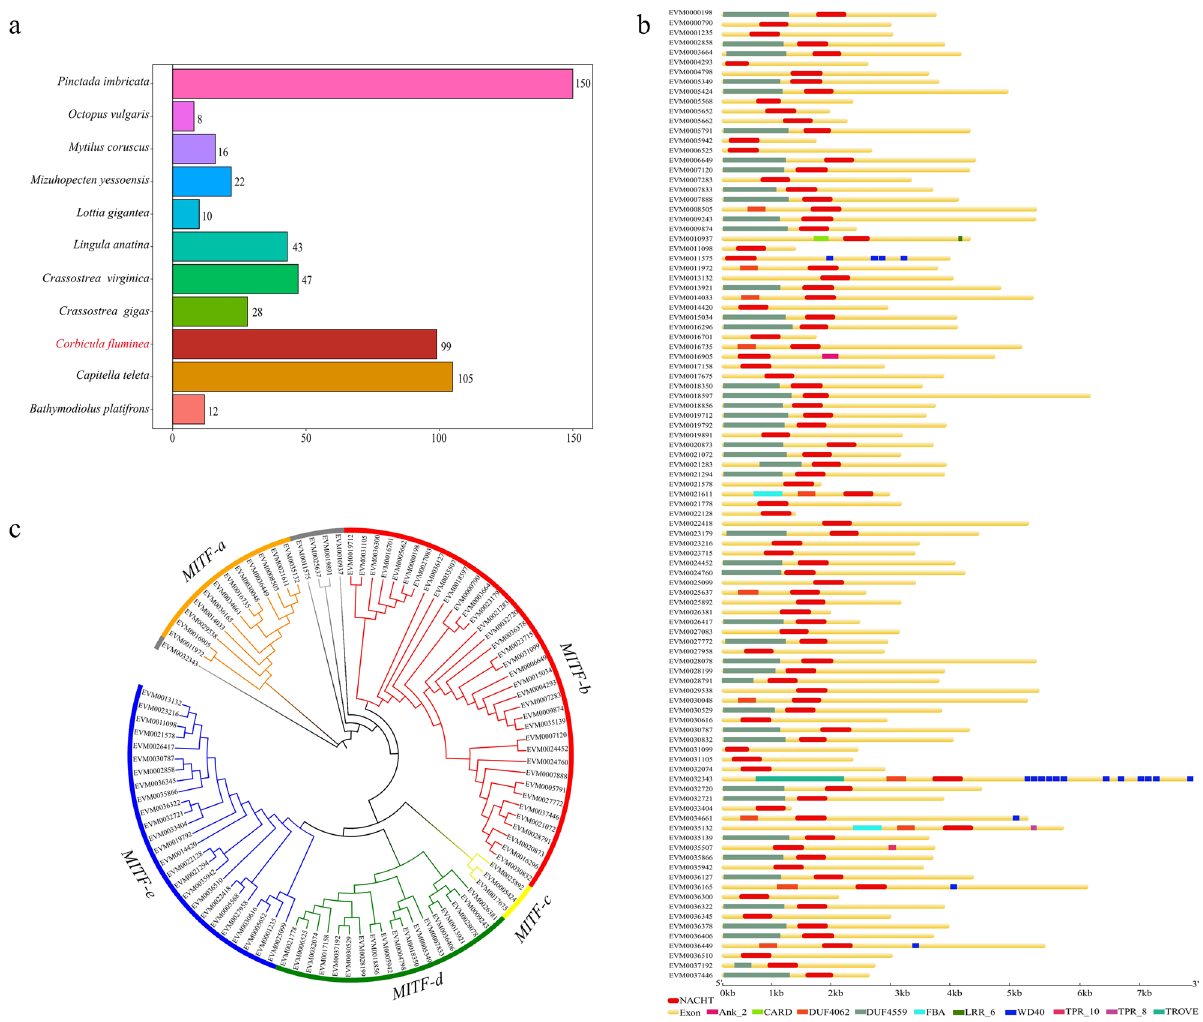
Figure 5. The analysis of NLRP gene family. ( a ) The number of NLRP members in Corbicula fluminea and other species. ( b ) The domains of NLRP members in C. fluminea. ( c ) NLRP members in C. fluminea were divided into five subfamilies, namely Subfamily